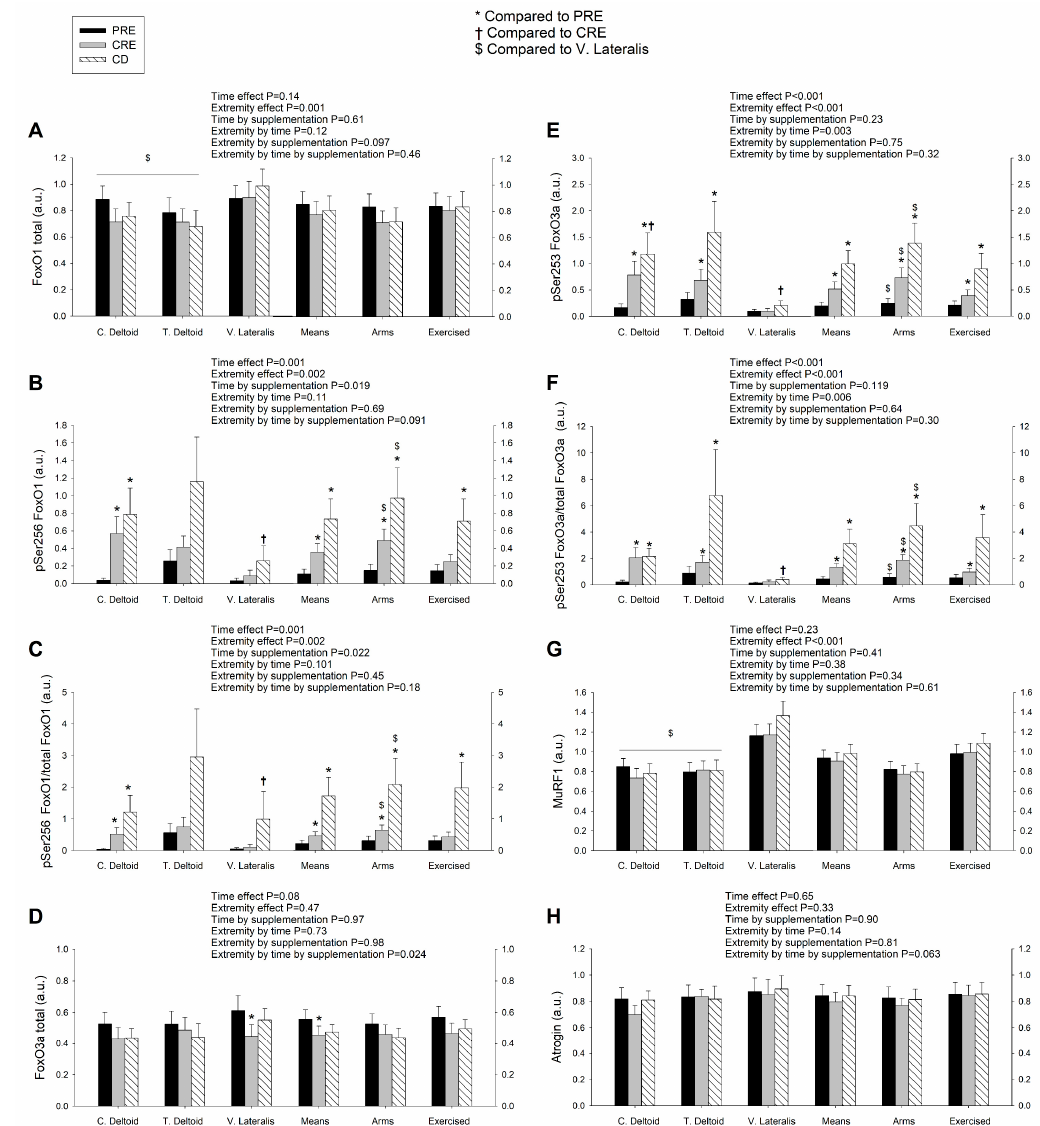
Figure 2. Exercise attenuates the increase of Ser256 FoxO1 and Ser253 FoxO3a elicited by severe energy deficit, without altering the markers of degradation by the ubiquitin-proteasome system. Protein expression levels of total, phosphorylated, and fractional phosphorylation of FoxO1 ( A – C ) and FoxO3a ( D – F ), E3 ligases MuRF1 ( G ) and MAFbx ( H ) in skeletal muscle following the three experimental phases. The various phases of the intervention are explained in Figure 1. PRE, before the intervention; CRE, caloric restriction and exercise; CD, control diet; C. Deltoid, control deltoid; T. Deltoid, trained deltoid; V. Lateralis, vastus lateralis; Means, (C. Deltoid + T. Deltoid + vastus lateralis) / 3; Deltoid muscles, (C. Deltoid + T. Deltoid) / 2; and Exercised, (T. Deltoid + vastus lateralis) / 2. n = 7 and n = 8 for the sucrose and whey protein groups, respectively. The statistical analysis was performed with logarithmically transformed data for all proteins except FoxO1 and MuRF1. The values shown are means ± standard errors and expressed in arbitrary units (a.u.). *, p < 0.05 compared to PRE; † , p < 0.05 compared to CRE; and $ , p < 0.05 compared to vastus lateralis. Note: The amount of Ser256 FoxO1 was almost undetectable in the vastus lateralis of the representative subject.